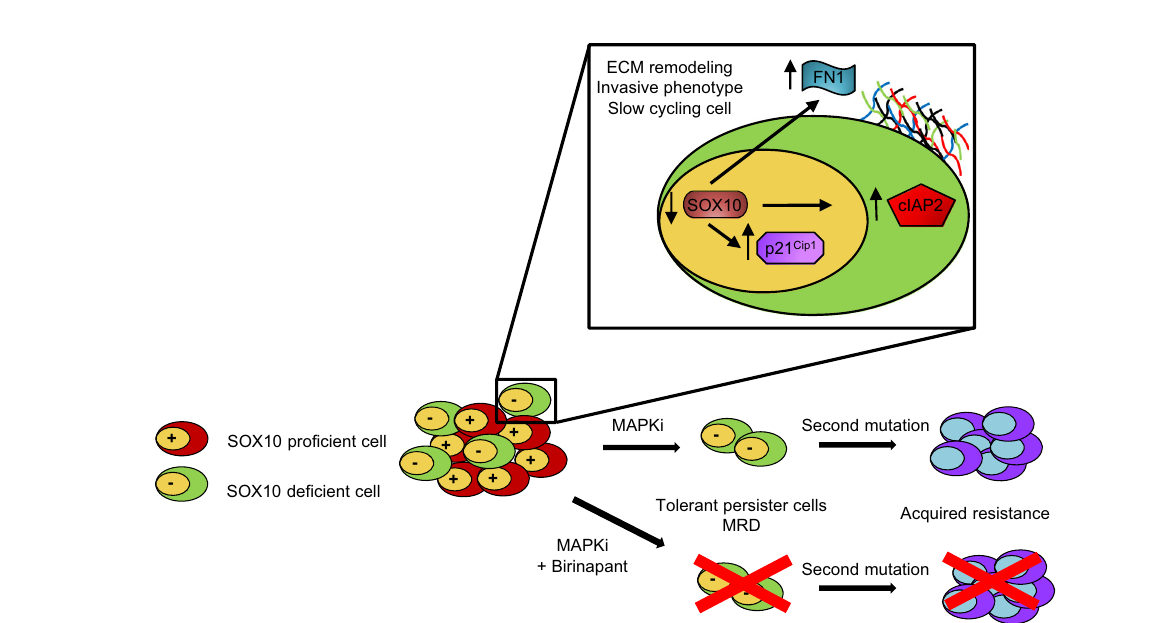
Fig. 7 Schematic showing the effects of SOX10 loss in melanoma. SOX10 loss leads to an invasive but dormant-like/quiescent phenotype associated with ECM remodeling and tolerance to MAPK targeting agents. SOX10-de fi cient cells show upregulation of cIAP2 that is associated with sensitivity to cIAP1/2 Generation of luciferase and fl uorescent-labeled cells . For luciferase labeling, MeWo parental and CRISPR SOX10 knockout cells were transduced with pLen- tipuro TO/V5-GW fi re fl y luciferase plasmid and selected for using puromycin. For mCherry labeling, MeWo cells were transduced with pLV-mCherry (Addgene #36084), and highly expressing cells were sorted. A similar approach was followed for GFP labeling of MeWo CRISPR knockout SOX10 #2.1 and #4.11 cells, except that the pLV-eGFP (Addgene #36083) plasmid was used. Inhibitors . Dabrafenib (BRAF inhibitor), PD0325901 (MEK inhibitor), trametinib (MEK inhibitor), and birinapant were purchased from Selleck Chemicals. PLX4720 (BRAF inhibitor), PLX2695 (MEK inhibitor), and PLX8394 (BRAF inhibitor) were provided by Dr. Gideon Bollag (Plexxikon Inc., Berkeley CA). Single-cell sequencing analysis . Single-cell RNA-Seq data for seven treatment- naïve and seven immune checkpoint inhibitor-resistant melanoma patient tumors originated from Jerby-Arnon, et al. 20 . These included tumors with at least 50 malignant cells. The Single Cell Portal (https://portals.broadinstitute.org/ single_cell/study/melanoma-immunotherapy-resistance) was used to generate tSNE plots of malignant cells. A loom fi le containing scRNA-seq data of 10 cutaneous melanoma cell lines from Wouters et al. 11 was obtained from http:// scope.aertslab.org/#/Wouters_Human_Melanoma. SCopeLoomR (v0.10.2 https:// github.com/aertslab/SCopeLoomR) was used to load preprocessed cell line data